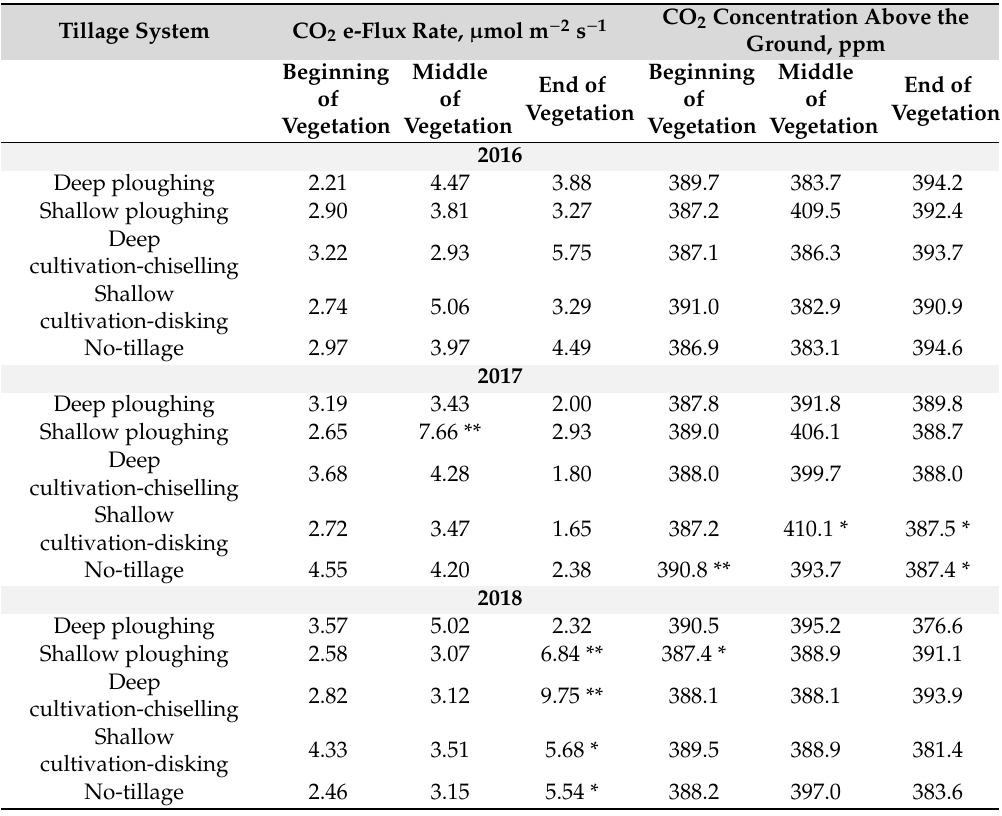
Table 6. The e ff ect of the tillage systems on the CO 2 e-flux and the concentration above the ground. Tillage